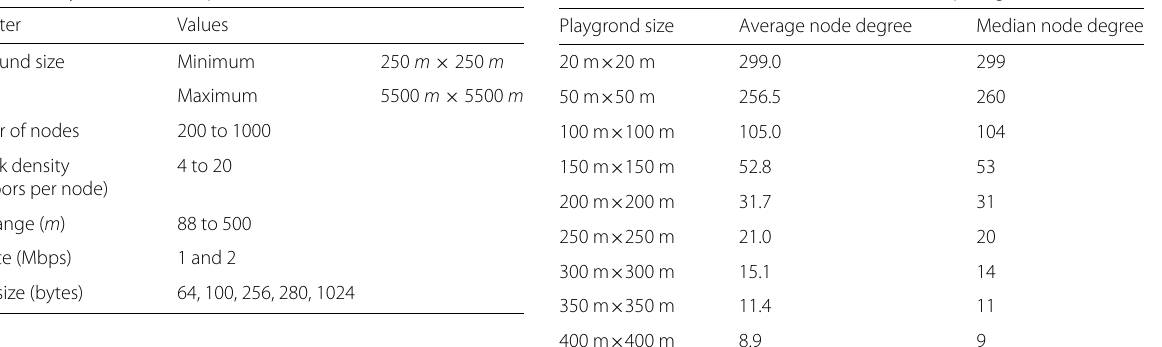
Table 9 Surveyed simulation parameters